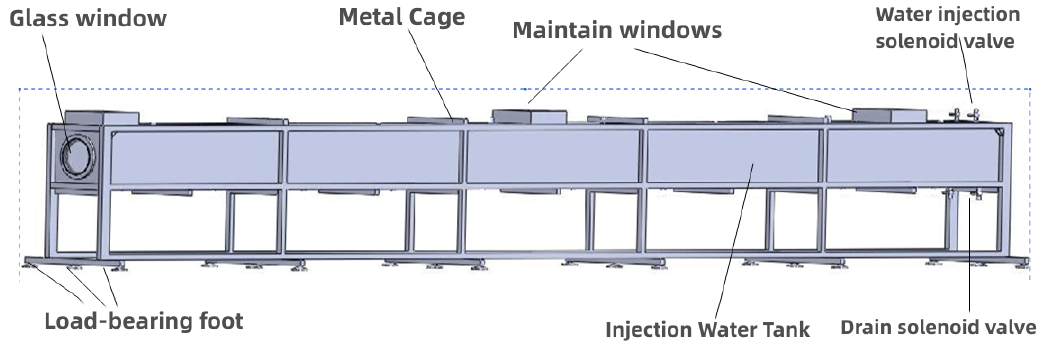
Figure 6. Structure diagram of simulated pool body. Table 3. Raw data of different underwater targets after reflection test.